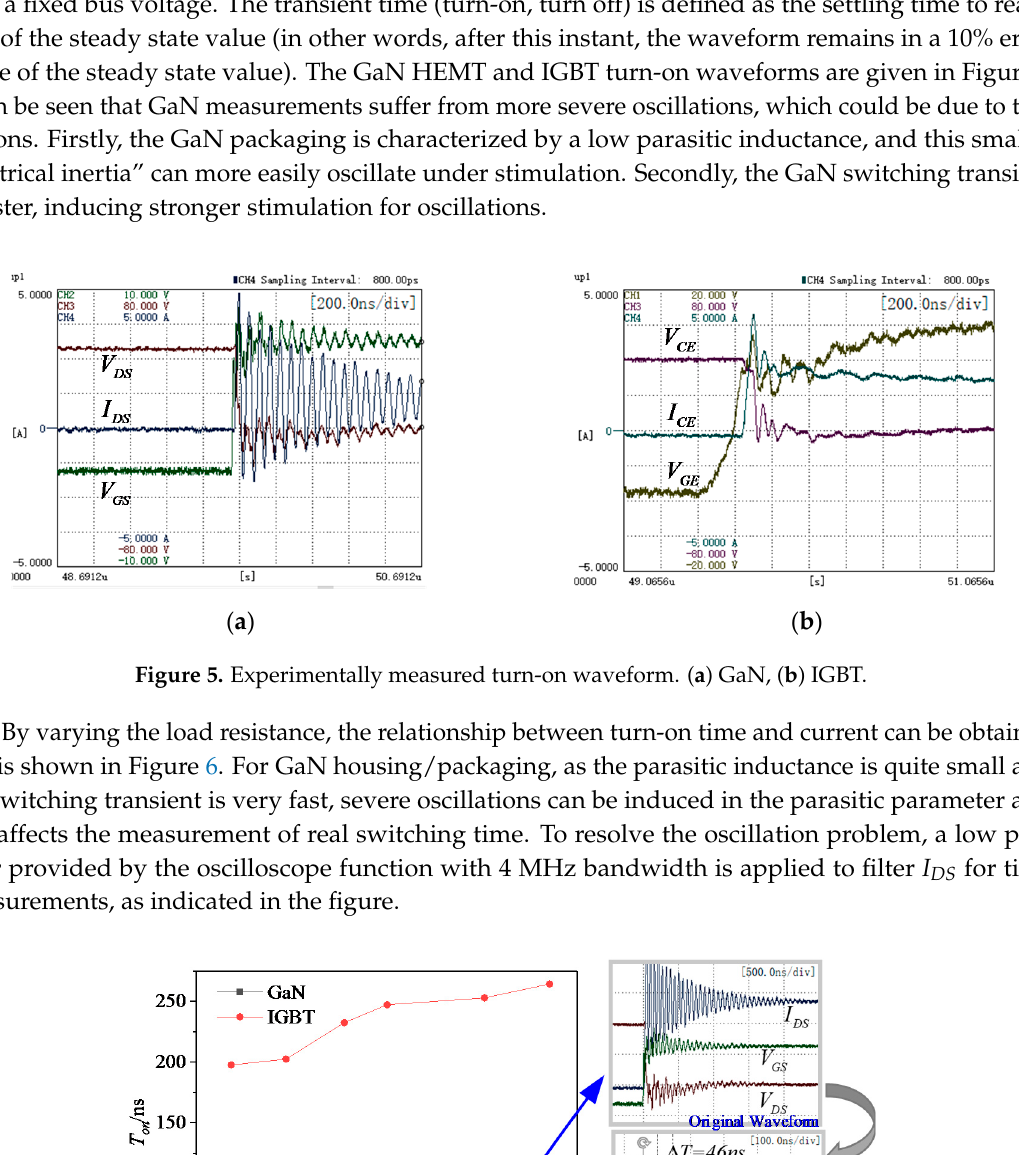
Figure 6. Experimentally measured GaN HEMT and IGBT turn-on time.